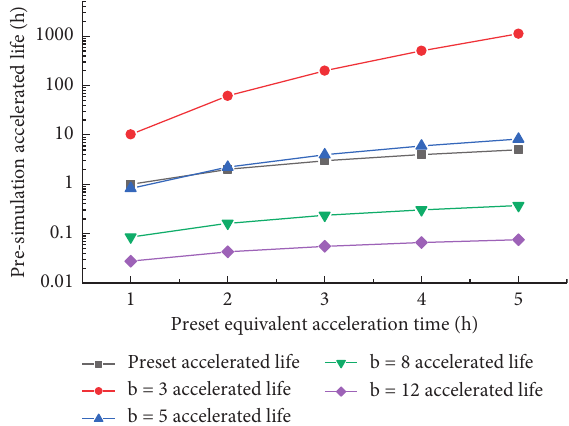
Figure 8: Pre-simulation acceleration fatigue lives at different equivalent acceleration